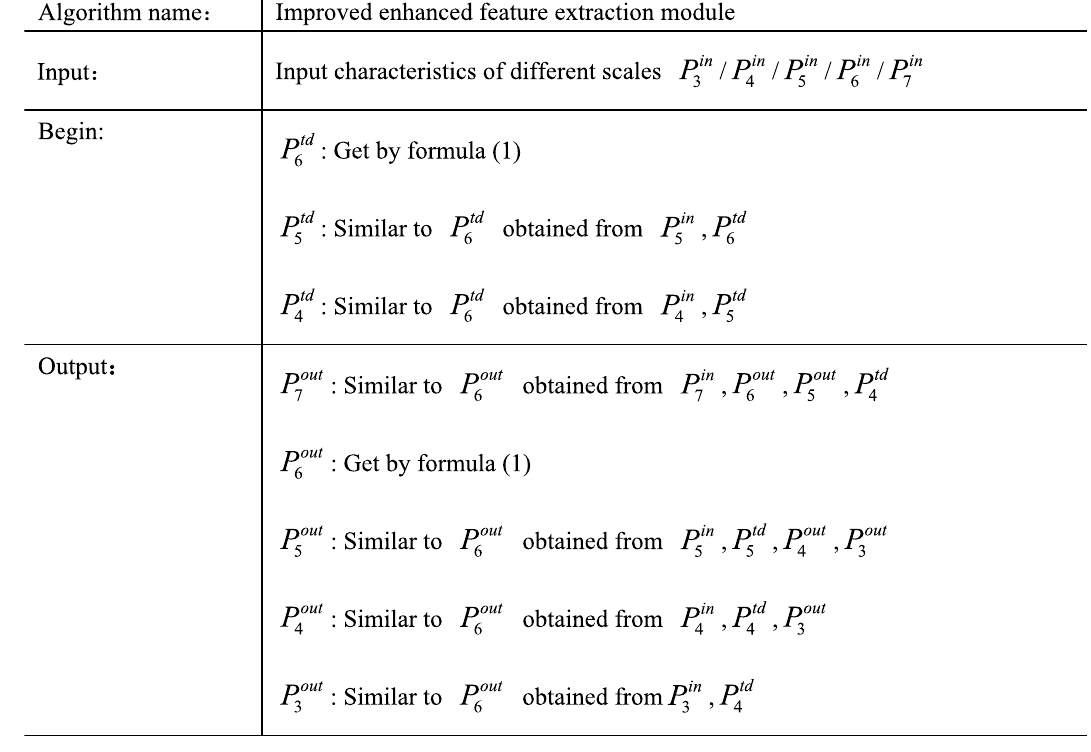
Figure 6. Improved enhanced feature extraction module